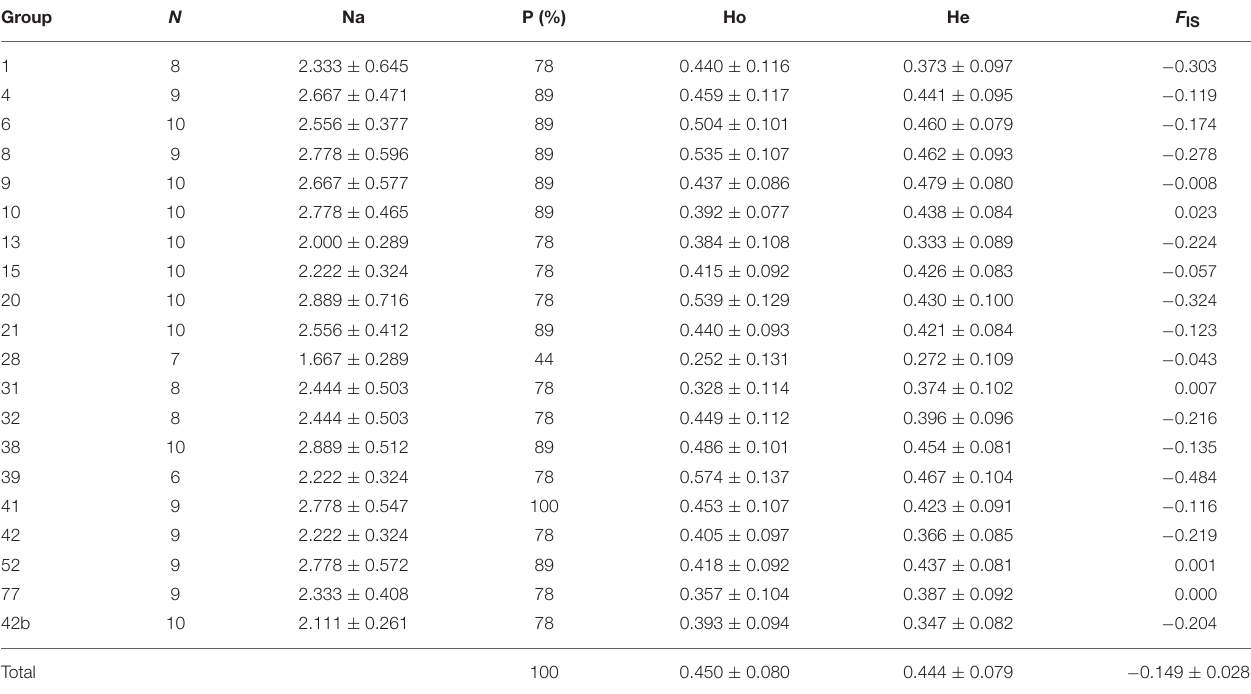
TABLE 1 | Genetic diversity of the 20 post fire seedling groups (each growing under different burned dead pine trees). Group N Na P (%)